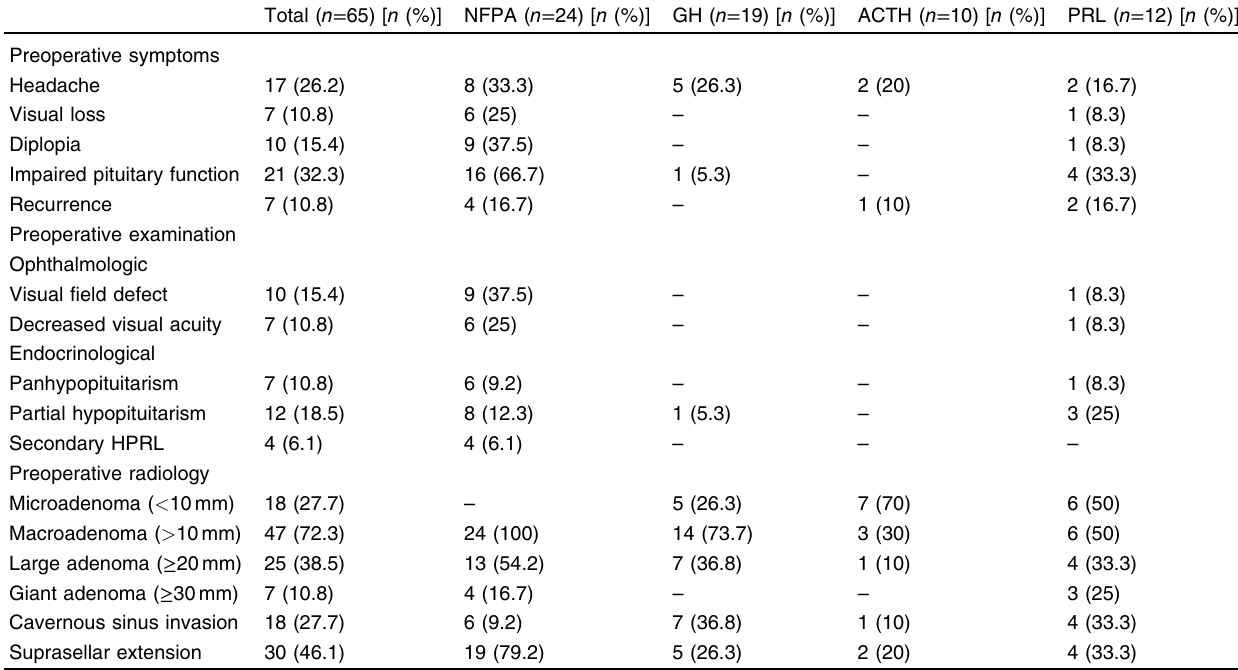
Table 1 Summary of preoperative characteristics in all patients